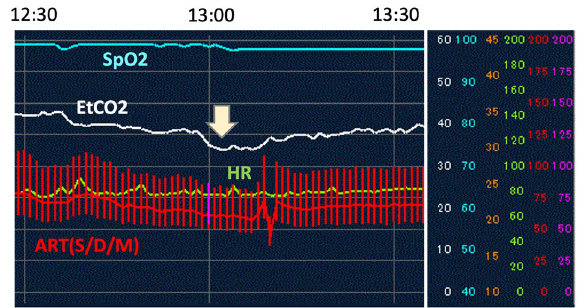
Figure 1. Intraoperative hemodynamic monitoring; TEE was performed immediately after a decrease in